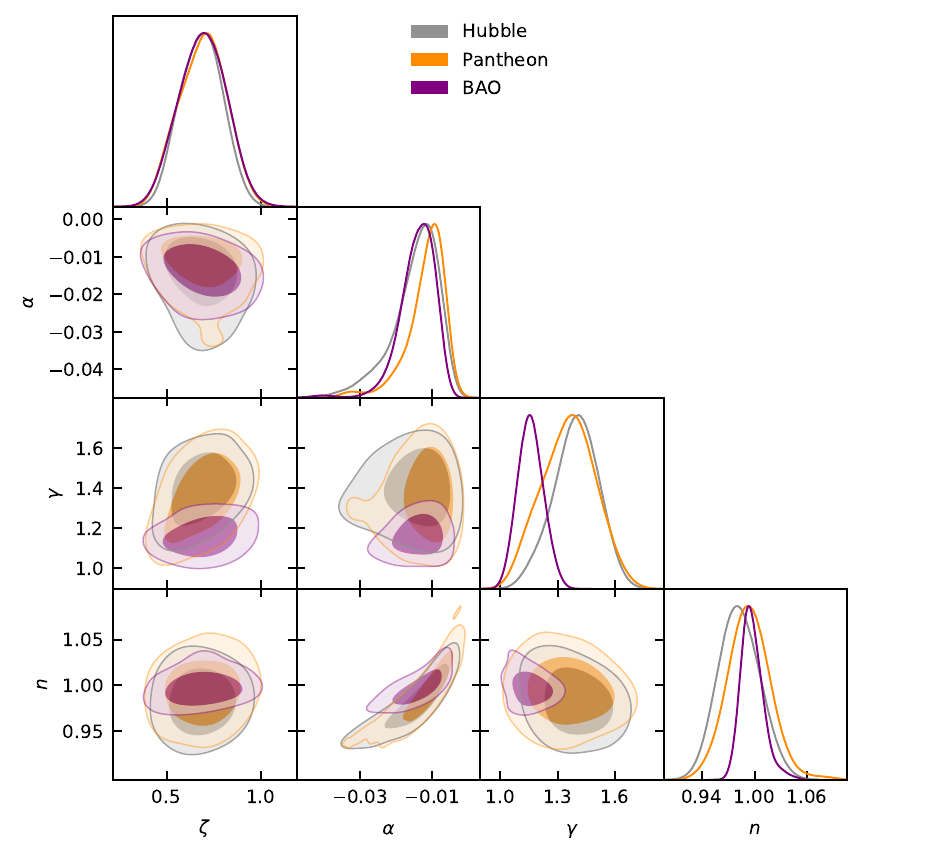
Figure 3. The 1 − σ and 2 − σ likelihood contours for the model parameters using the Hubble, BAO, and the Pantheon